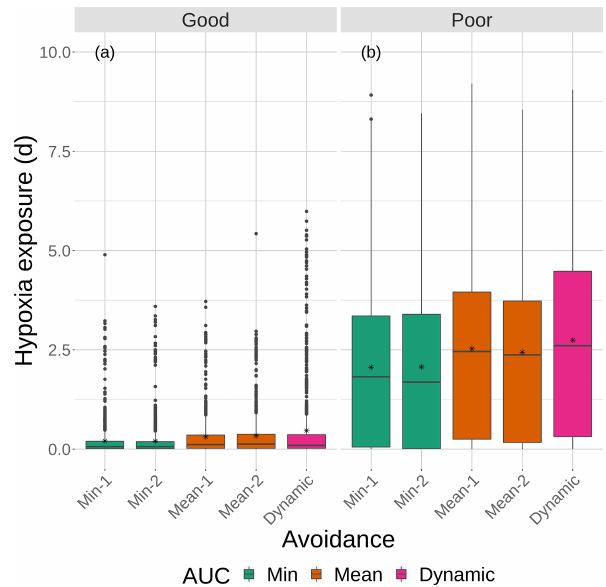
Figure 9. Boxplots of cumulative hypoxia exposure of all individu- als (days) for good and poor competency on the four snapshot DO maps with moderate sublethal area. The cumulative exposure for the simulation using the dynamic map is also shown. The lower and upper lines of the boxplots show the 25th and 75th percentile value of cumulative exposure, and the center line is the median. Individ- ual fish values flagged as extreme values are shown as individual points. The star symbol denotes the